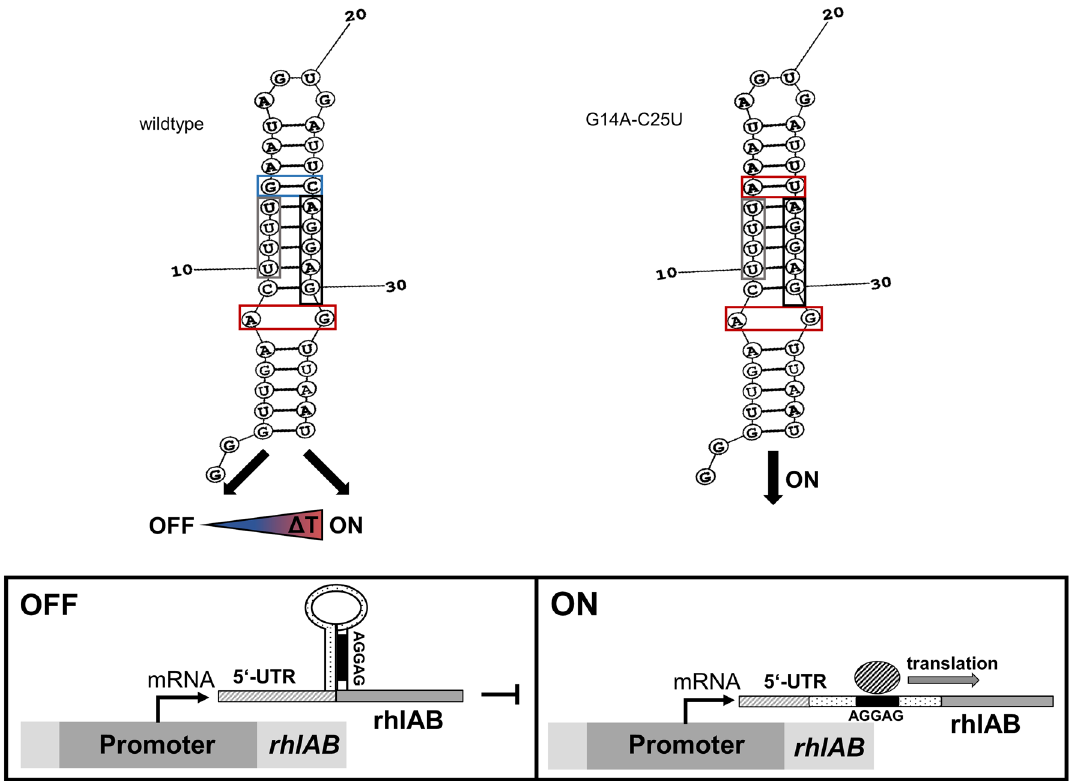
Figure 1. Working principal, hairpin structure and RNA sequence of Salmonella wild type fourU RNAT and destabilized (G14A-C25U) mutant used in this study. Base pairs framed in red are less stable than base pairs framed in blue, grey frames indicate the fourU motive and black frames the Shine-Dalgarno sequence. (Adapted from 29